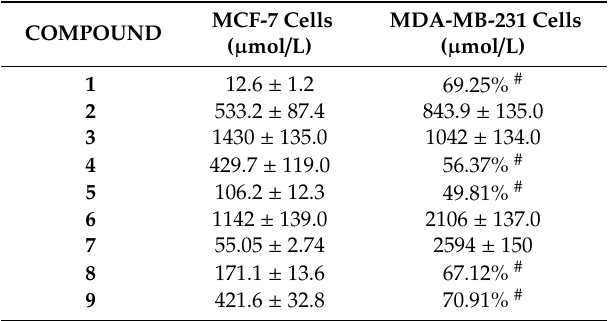
Table 3. The e ff ects of metformin derivatives on the inhibition of MCF-7 and MDA-MB-231 cells’ viability. The results (IC 50 values, µ mol / L) are presented as mean ± SD ( n = 6–8). MCF-7 Cells COMPOUND ( µ mol /